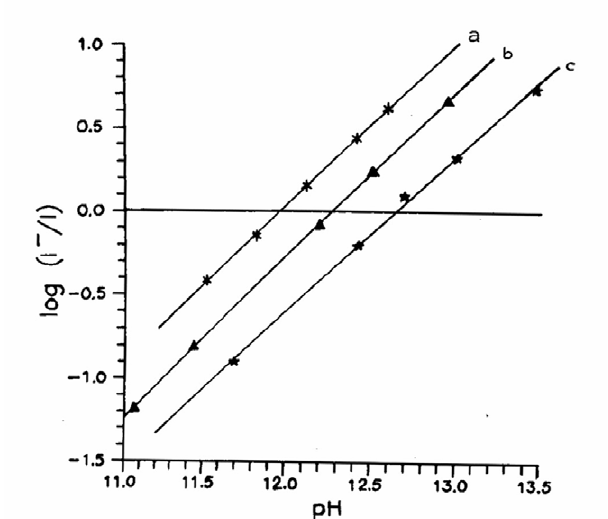
Figure 2. Plot of log(I ─ /I) vs. pH of the solution: (a) CAZL – NaOH; (b) INDZ –NaOH; (c) 2HB – NaOH.